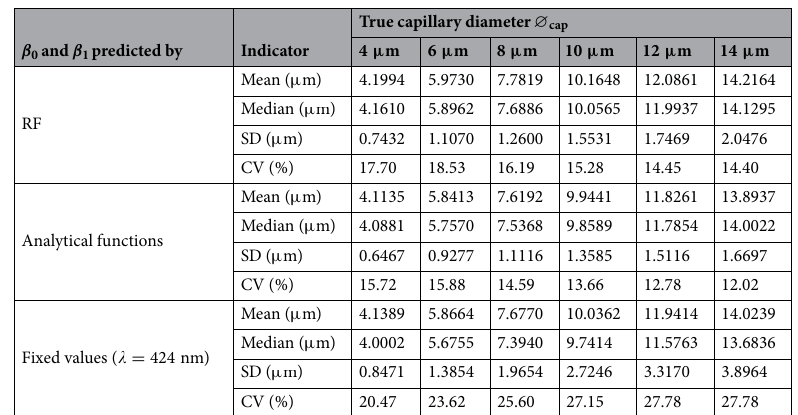
Table 2. Results from the prediction of the capillary diameters separated by the three prediction methods investigated. The mean and median values, standard deviations and coefficients of variation (CV) for all methods and capillary diameters are given. A graphical representation of this data can be found in Fig. 5.